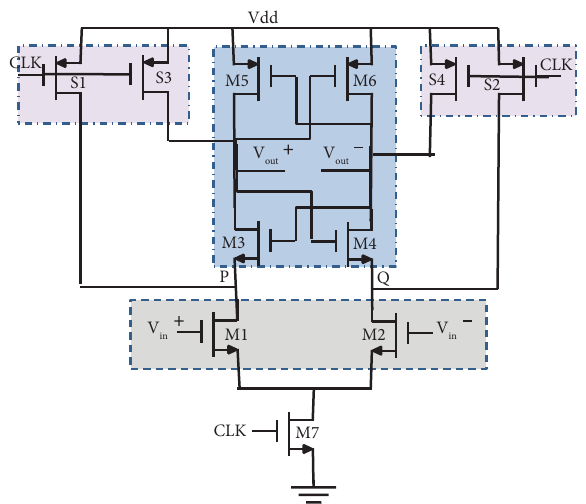
Figure 5: Te basic structure of the single-stage dynamic latch comparator.